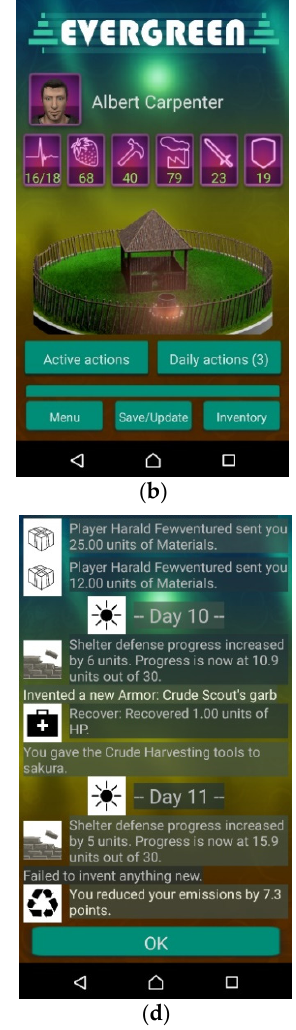
Figure 9. Screenshots from the Android version of the game Evergreen. ( a ) Splash screen. ( b ) Main screen, showing statistics in the top 6 icons. ( c ) ‘Daily Actions’ selection screen. ( d ) The results screen displays what has happened during the most recent days/turns.